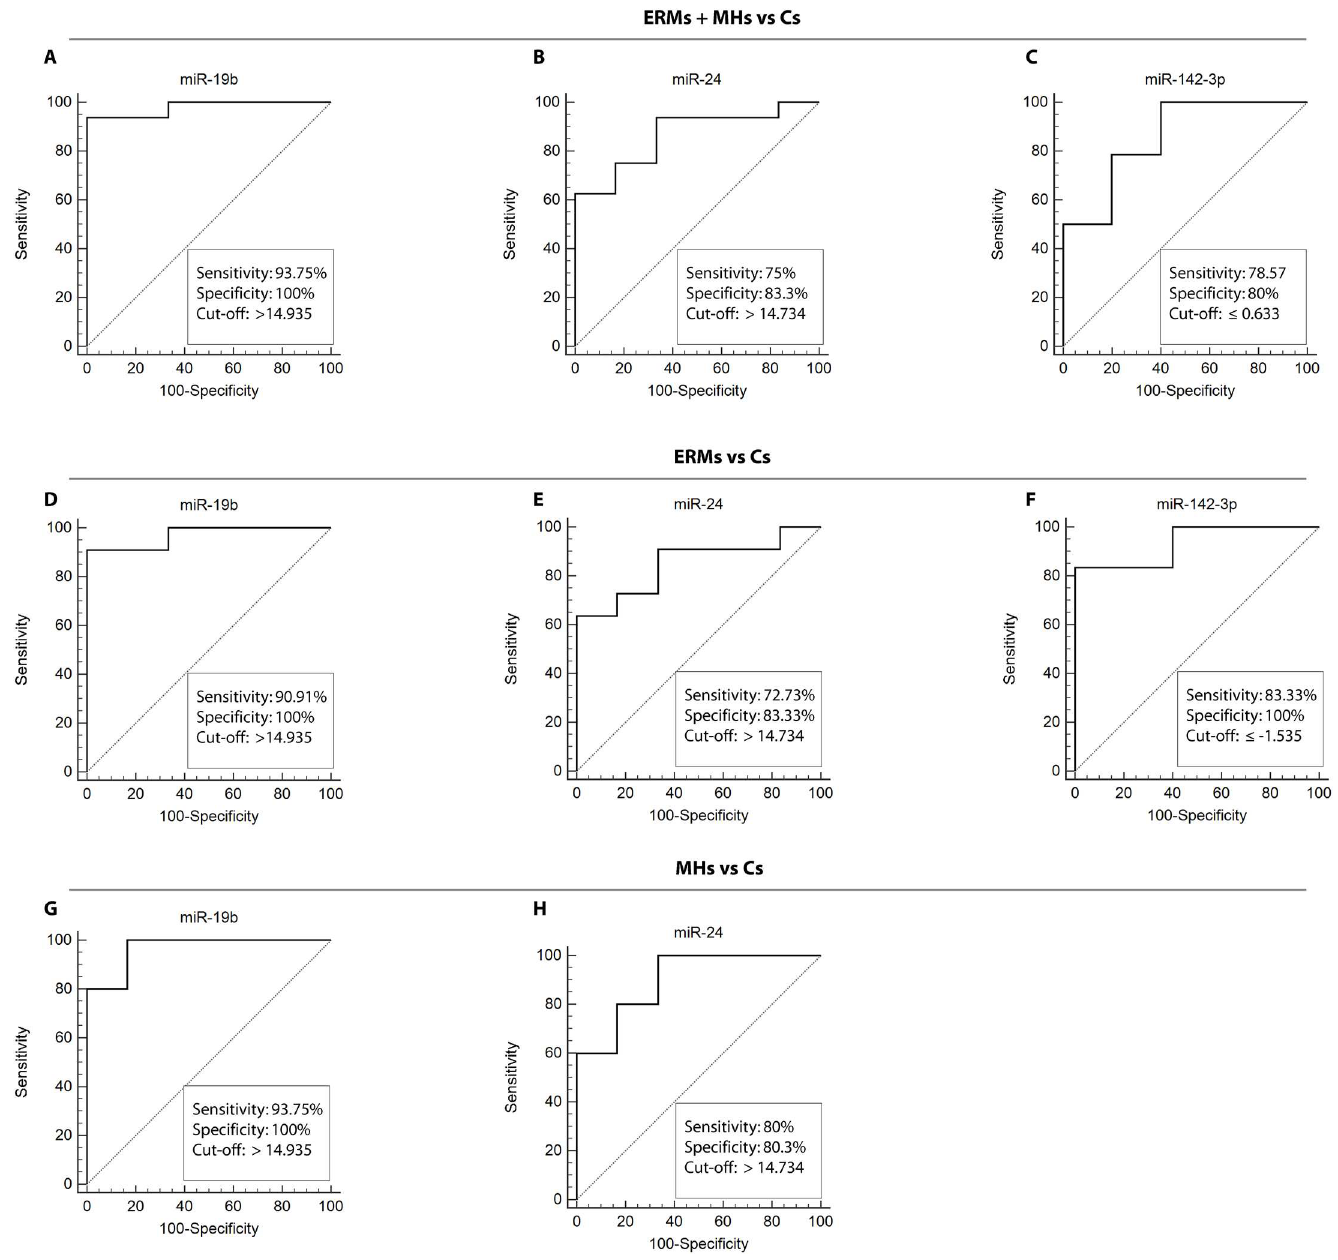
Fig 3. ReceiverOperator Characteristic (ROC) curves for vitreal miR-19b, miR-24 and miR-142-3p in patients affected by MHs and ERMs. ROC curves of miR-19b(A), miR-24 (B), miR-142-3p(C) DCts in comparisonwith ERMs + MHs vs controls; miR-19b(D), miR-24 (E), miR-142-3p (F) DCts in comparisonwith ERMs vs controls; miR-19b(D), miR-24 (E) in comparisonwith MHs vs controls. Curves represent DCts calculatedby using U6 as endogenous control.